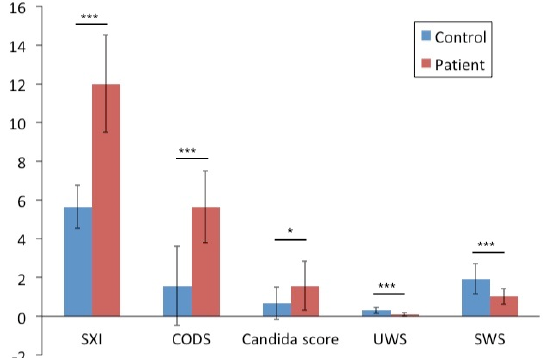
Figure 3. Clinical oral evaluations in patients and controls. Radiated head and neck cancer patients displayed significantly higher mean oral dryness score compared to the healthy controls in terms of both the subjective Summated Xerostomia Inventory (SXI) questionnaire and the objective Clinical